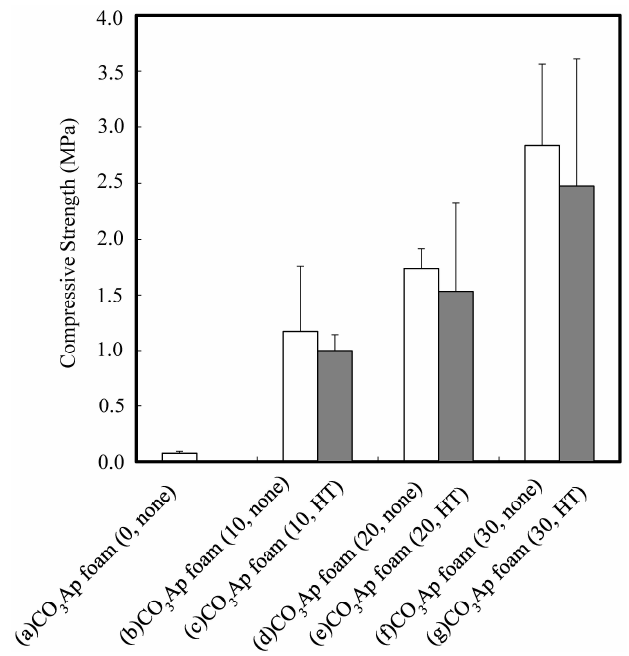
Figure 5. Compressive strength of CO 3 Ap foams: ( a ) CO 3 Ap foam (0, none); ( b ) CO 3 Ap foam (10, none); ( c ) CO 3 Ap foam (10, HT); ( d ) CO 3 Ap foam (20, none); ( e ) CO 3 Ap foam (20, HT); ( f ) CO 3 Ap foam (30, none); and ( g ) CO 3 Ap foam (30, HT) CO 3 Ap foam. Sample number in each group was five.